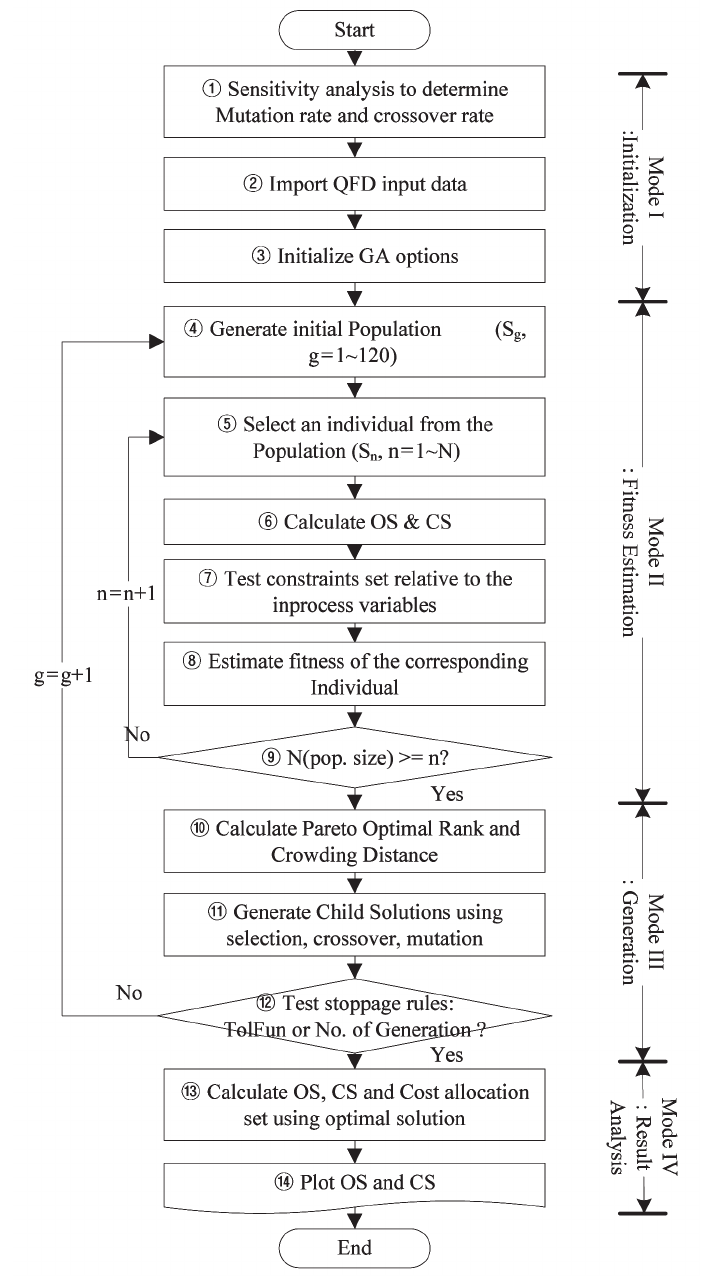
Fig. 2. Curtain-wall Quality-Cost optimization